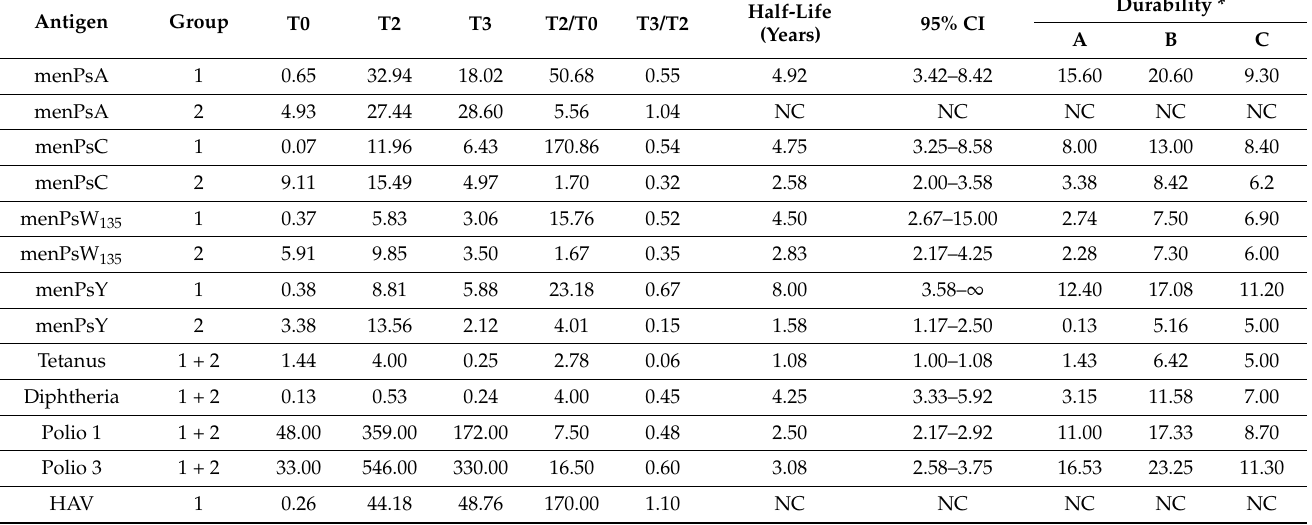
Table 4. Geometric mean concentrations of anti-meningococcal polysaccharides (menPs) A, C, W 135 , Y, anti-tetanus, and diphtheria toxoids, anti-hepatitis A virus (HAV), and geometric mean titers of anti- polio 1 and 3 in the military of both groups pre- (T0), 9-month (T2) and 5-year (T3) post-vaccination, as well as the T2/T0 and T3/T2 ratios, are reported. Half-life of vaccine-induced antibodies, with their 95% confidence interval (CI), as well as antibody durability above the putative threshold for protection in years are also